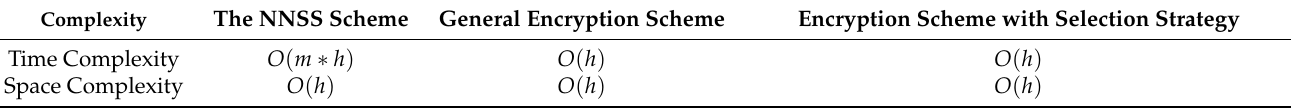
Table 3. The comparison of the NNSS scheme with other encryption